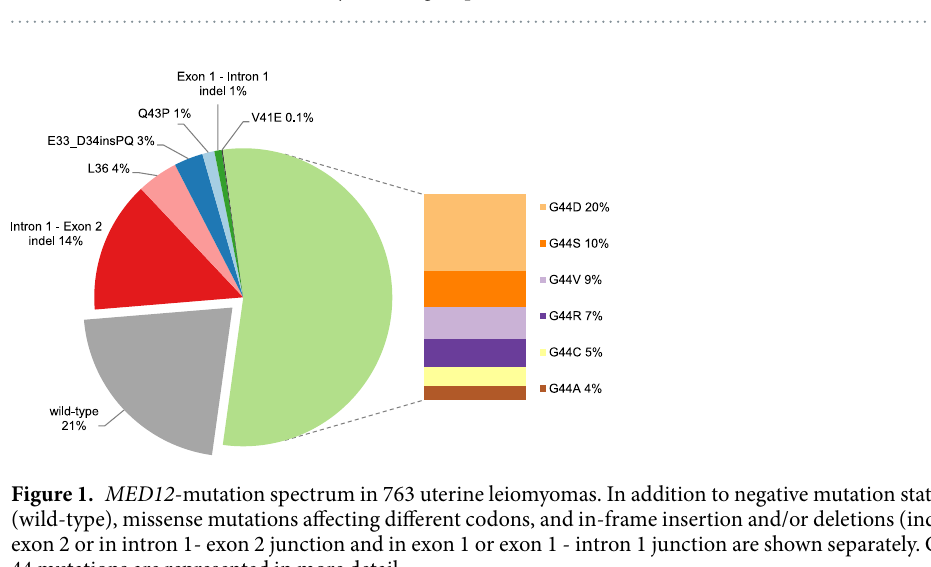
Table 1. MED12 mutations in leiomyoma subgroups.